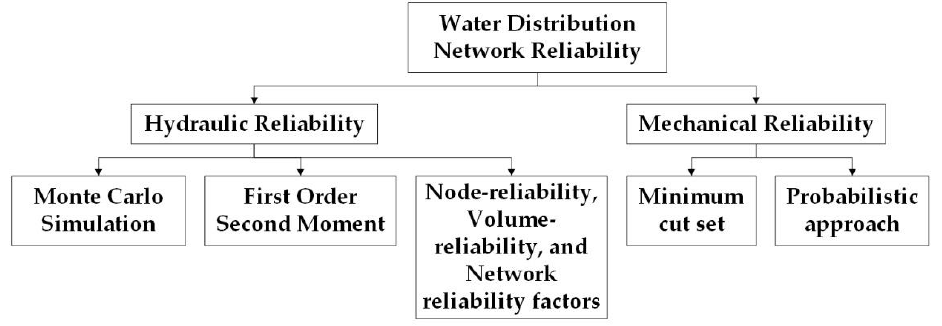
Figure 1. Classification of reliability assessment